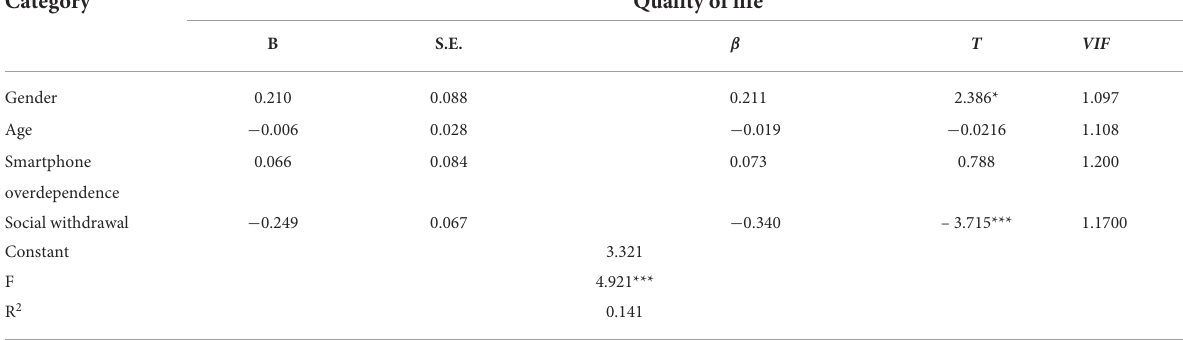
TABLE 6 Relationship of smartphone overdependence and social withdrawal with quality of life. Category